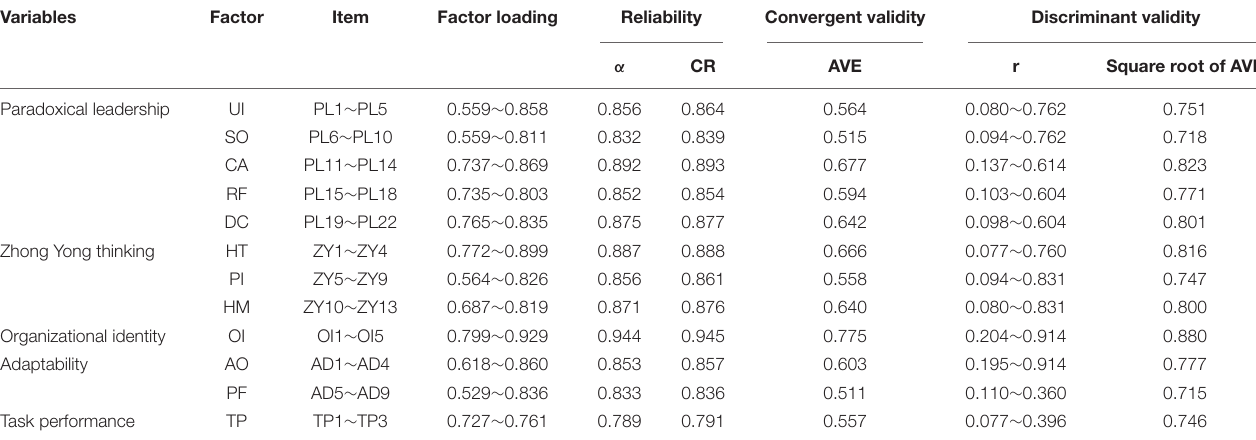
TABLE 1 | Internal consistency reliability, composition reliability, convergent validity, and discriminant validity.